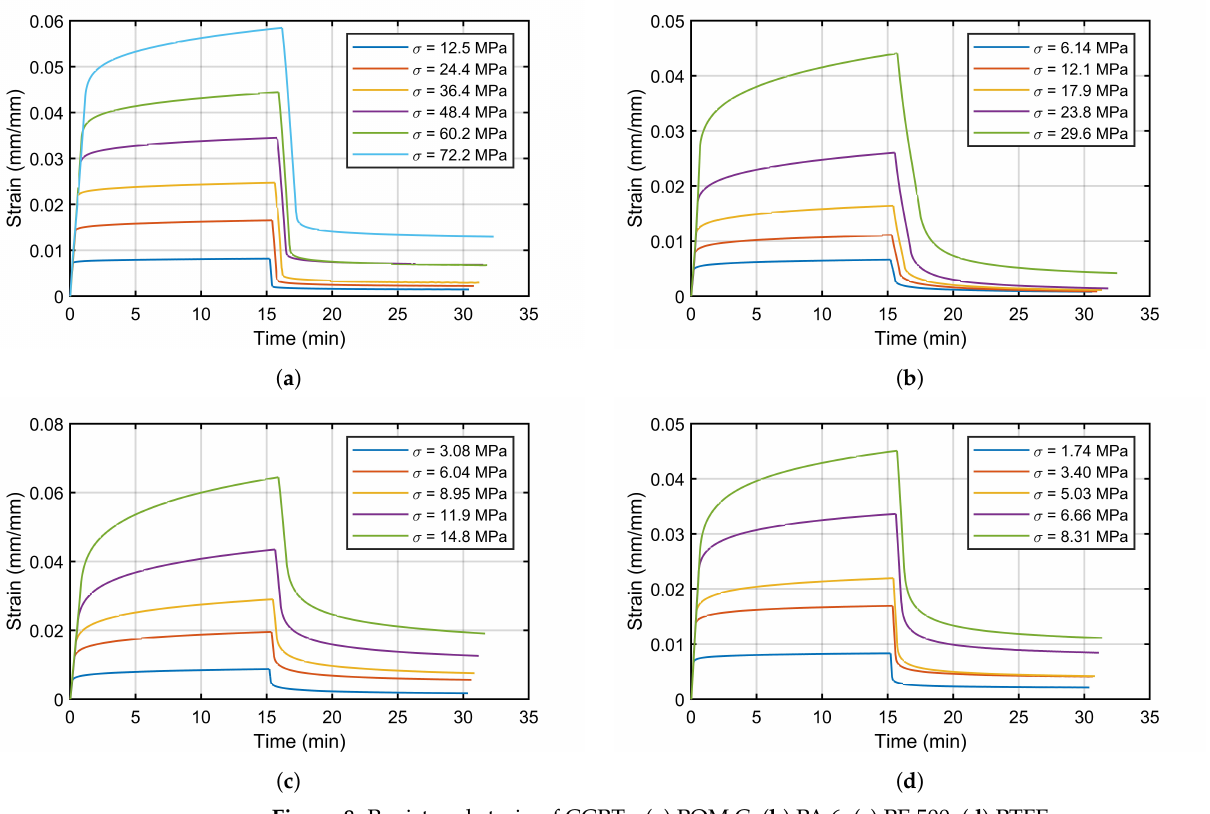
Figure 8. Registered strain of CCRTs: ( a ) POM C; ( b ) PA 6; ( c ) PE 500; ( d ) PTFE.